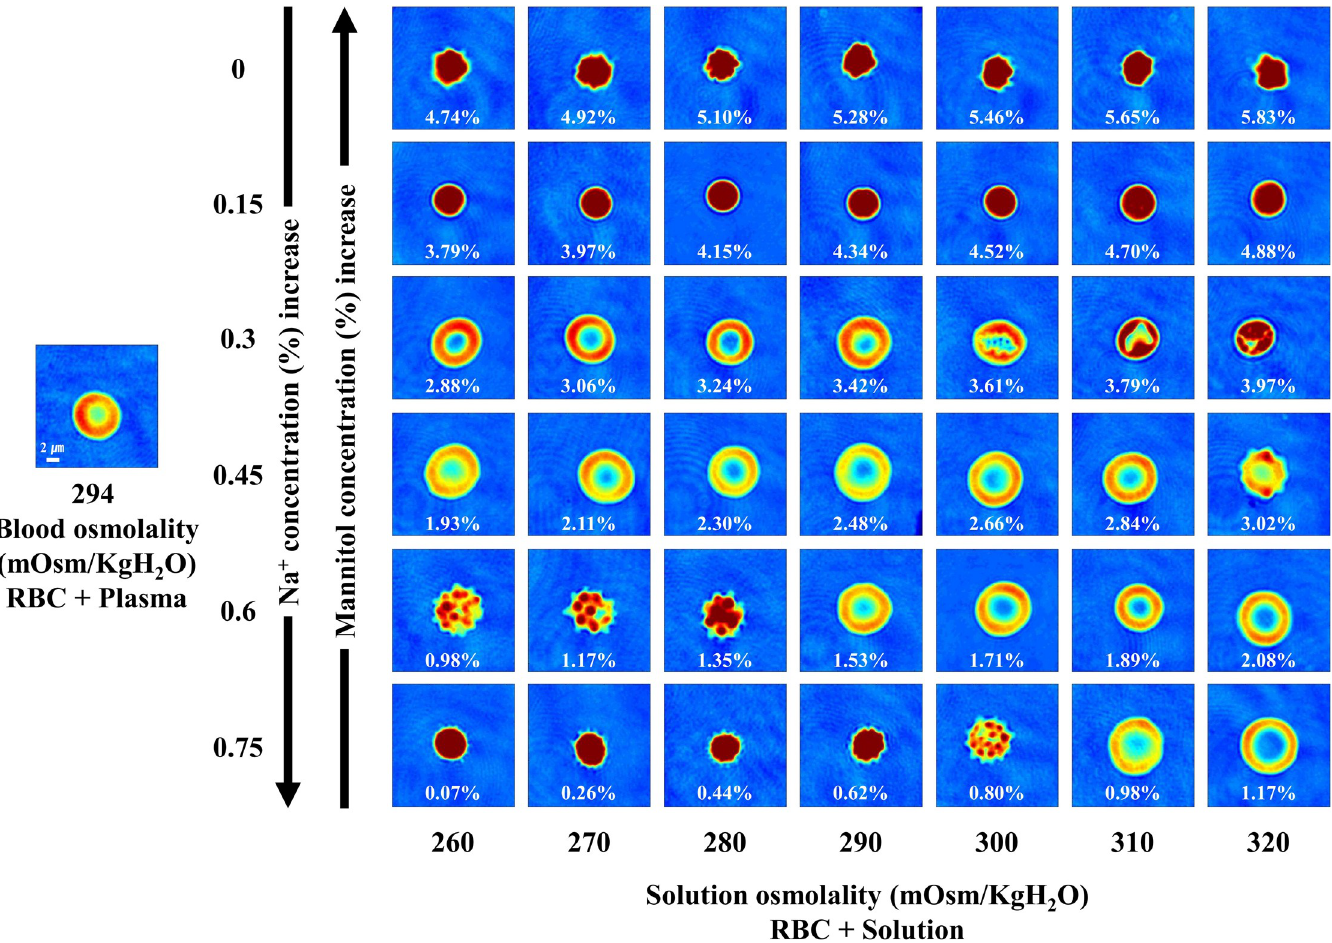
Fig 4. 2D images presenting the morphology of RBCs for one healthy subject in sodium chloride and mannitol solutions. The level of sodium chloride was fixed at 0%, 0.15%, 0.3%, 0.45%, 0.6%, and 0.75%, and mannitol was mixed according to the respective osmolality. The value in each panel represents the concentration of